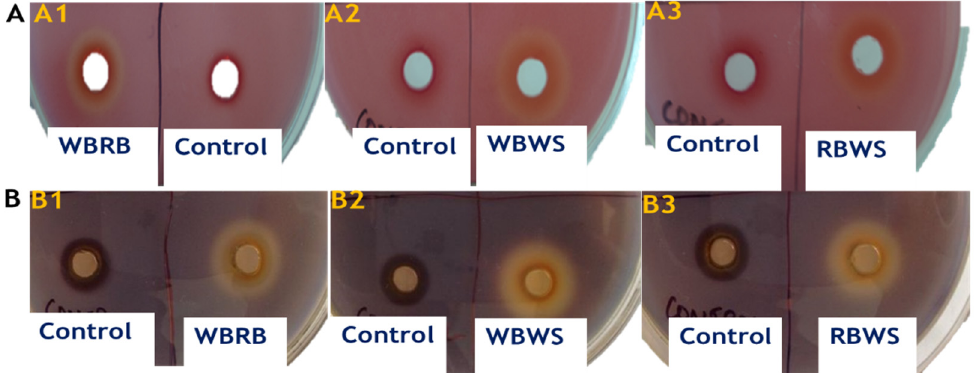
Figure 1. Qualitative determination of lignocellulolytic enzyme activities including carboxymethyl cellulase (CMCase) activity by disc diffusion method ( A ) and xylanase activity by xylan agar dye staining ( B ) in the presence of WBRB (A1, B1), WBWS (A2, B2), and RBWS (A3, B3). A clear-looking circle around the disc indicates the presence of enzymes, while the nonappearance of the circle around the disc shows the absence of enzymes. Agro-industrial waste as a substrate in solid-state fermentation (SSF) by Fusarium oxysporum MTCC 7229: wheat bran + rice bran (WBRB), wheat bran + wheat straw (WBWS), rice bran + wheat straw (RBWS), and control = individual combinations of agro-industrial waste without fungi.